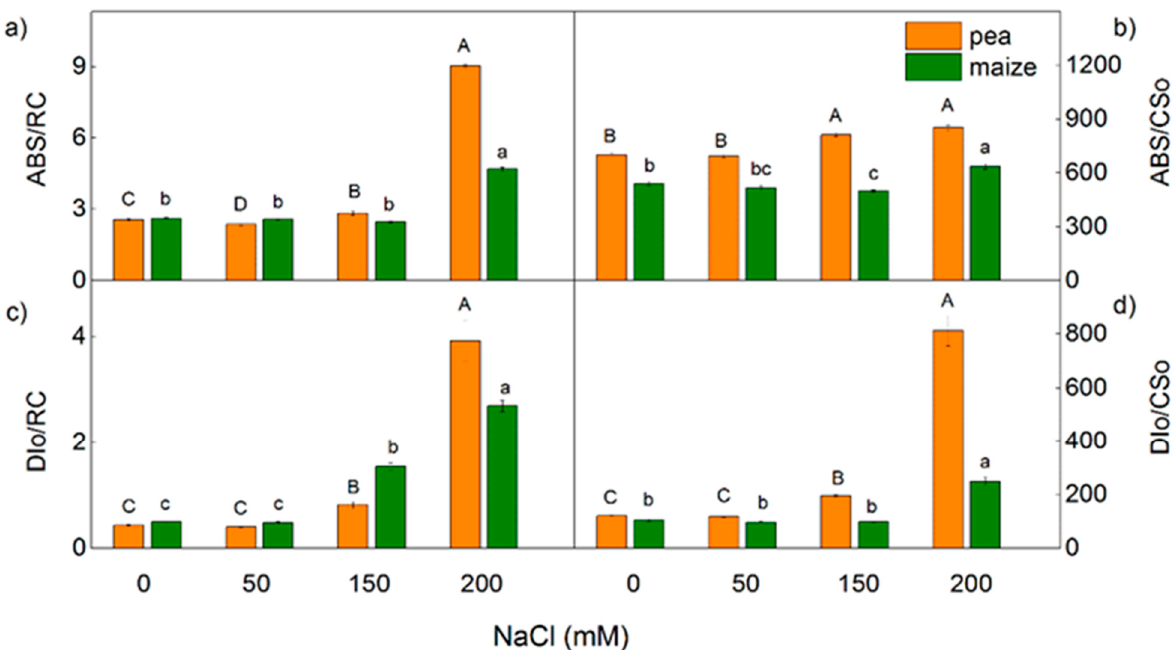
Figure 9. Effects of different NaCl concentrations on the selected JIP parameters (Table 1) in leaves of pea and maize. ( a ) absorption flux per RC (ABS/RC), ( b ) light energy absorption flux per CS (ABS/CSo), ( c ) dissipated energy flux per RC (DIo/RC), ( d ) dissipated energy flux per CS (DIo/CSo). The parameters are in relative units. Mean values (±SE) are from 20 independent measurements. Different letters indicate significant differences for the respective parameters at p < 0.05 (uppercase for pea and lowercase for maize).